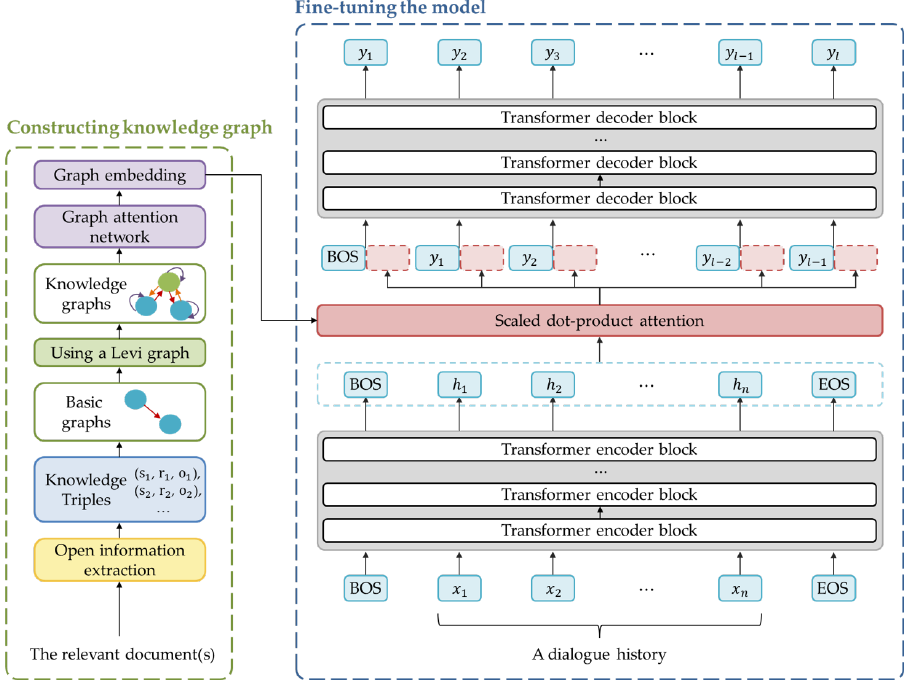
Figure 6. The overall architecture of the proposed model. The model comprises two parts; construct- ing knowledge graph and fine-tuning the model. The red dotted blocks indicate the attention scores that are calculated by using a scaled-dot